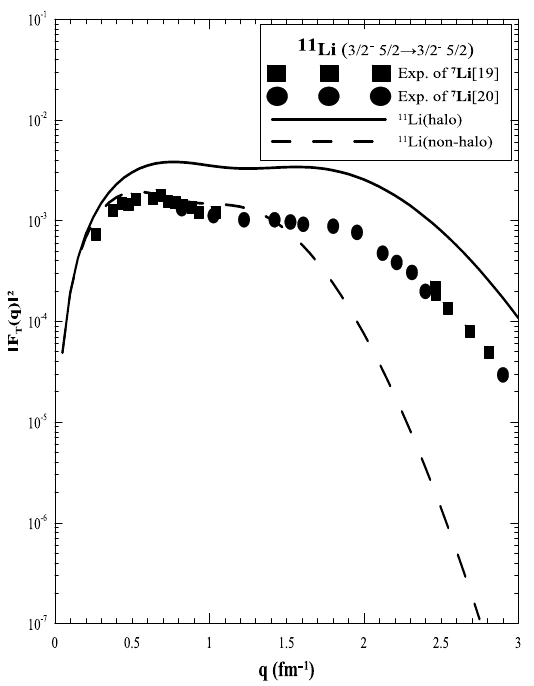
Fig. 5: Comparison between the total form factors of 11 Li (non-halo) (dashed curve) and 11 Li (halo) (solid curve) with the experimental data of 7 Li nucleus.